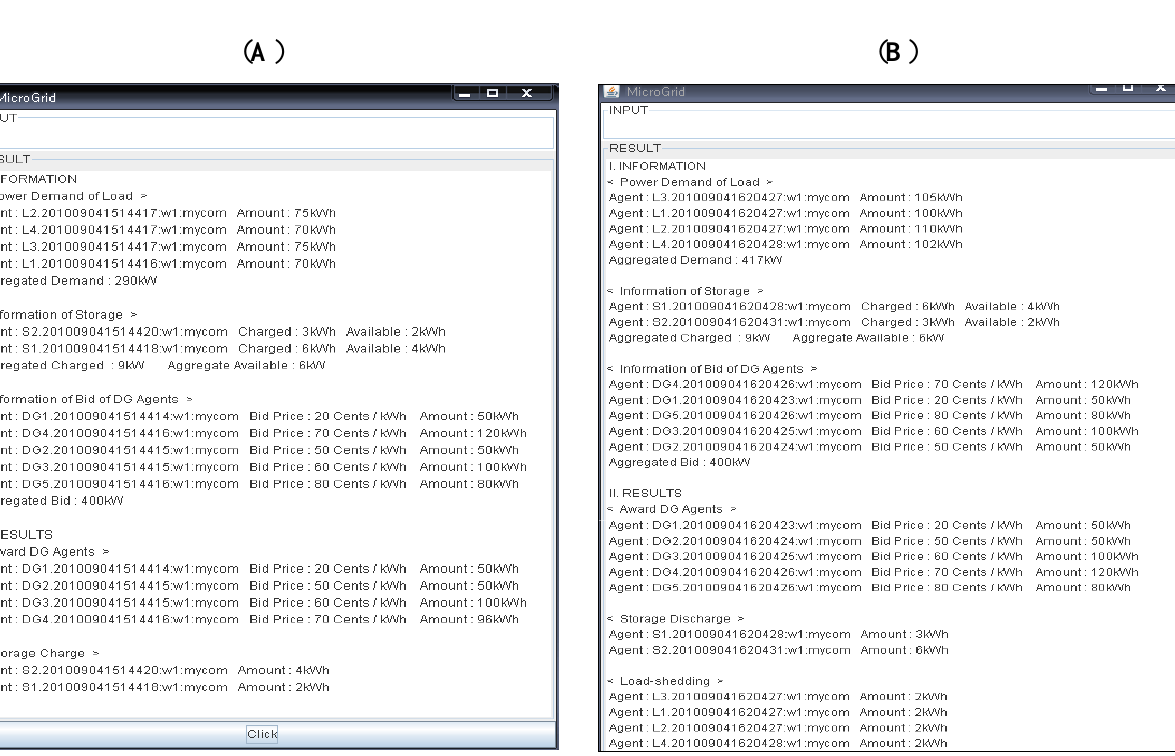
Figure 11. Result of ( A ) Case 5; ( B ) Case